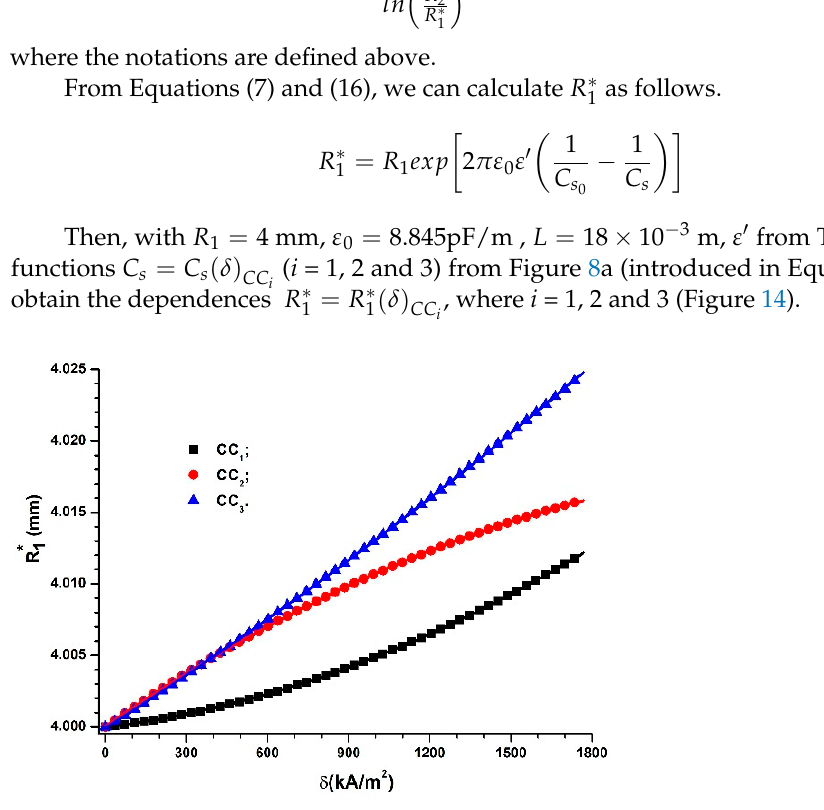
Figure 14. Apparent radius, R ∗ , of CCs as function of the gradient of magnetic field intensity, δ . 1 As we can observe from Figure 14, R ∗ is dependent on the volumetric fraction of 1 CIPs, Φ CIP . For values of δ ≥ 750kA/m 2 , the values of the apparent radius are distinct and increase with an increase in the magnetic field intensity gradient, δ . The metallic magnetizable phase is not uniformly distributed around the internal cylinder